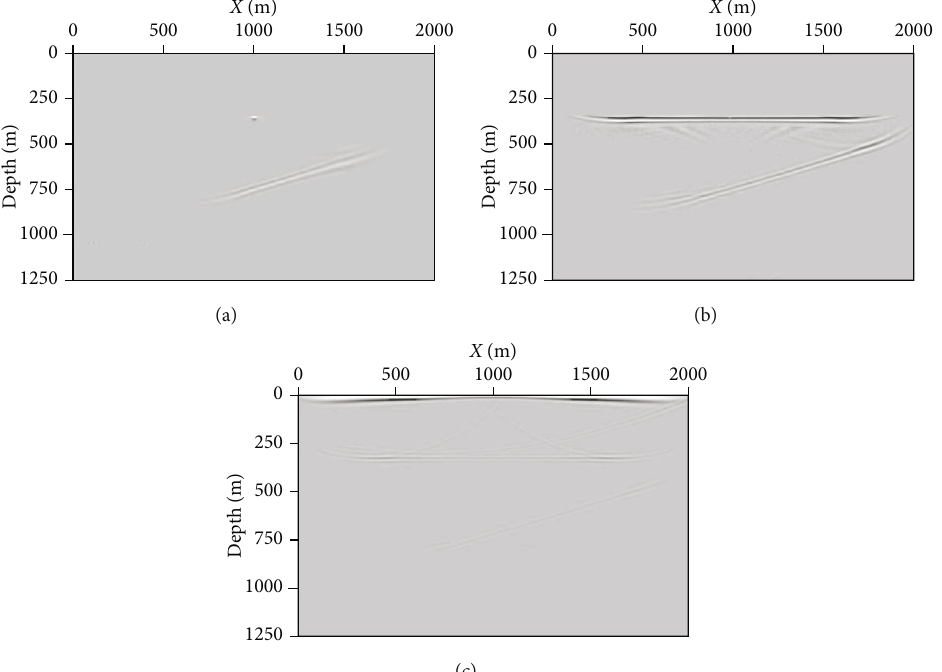
Figure 7: The comparison of imaging results. Imaging results of (a) primary waves and (b) multiple waves by two-way wave equation depth migration method; (c) imaging result of multiple waves by reverse time migration method.